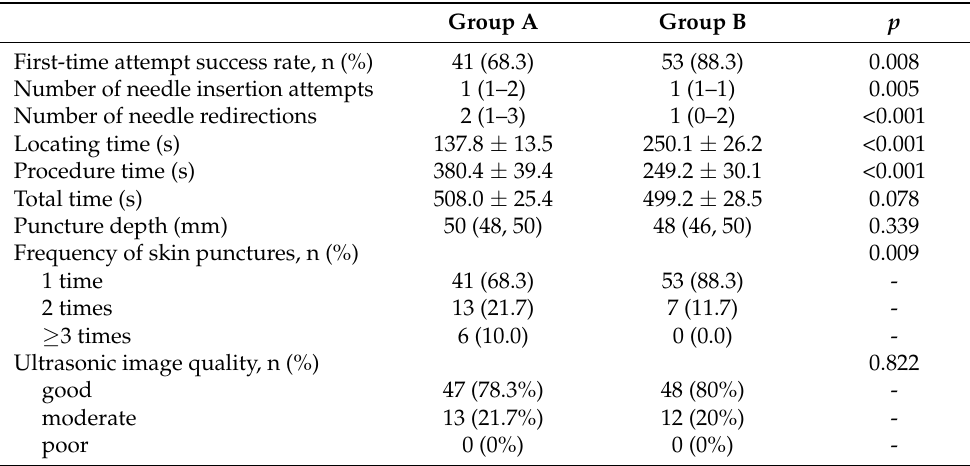
Table 2. Comparison of outcomes between the two